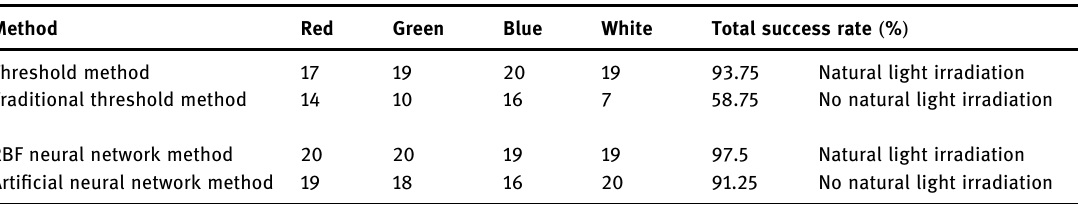
Table 2: Color recognition results under di ff erent conditions Each color is recognized 20 times in total. The following table shows the successful recognition times of each